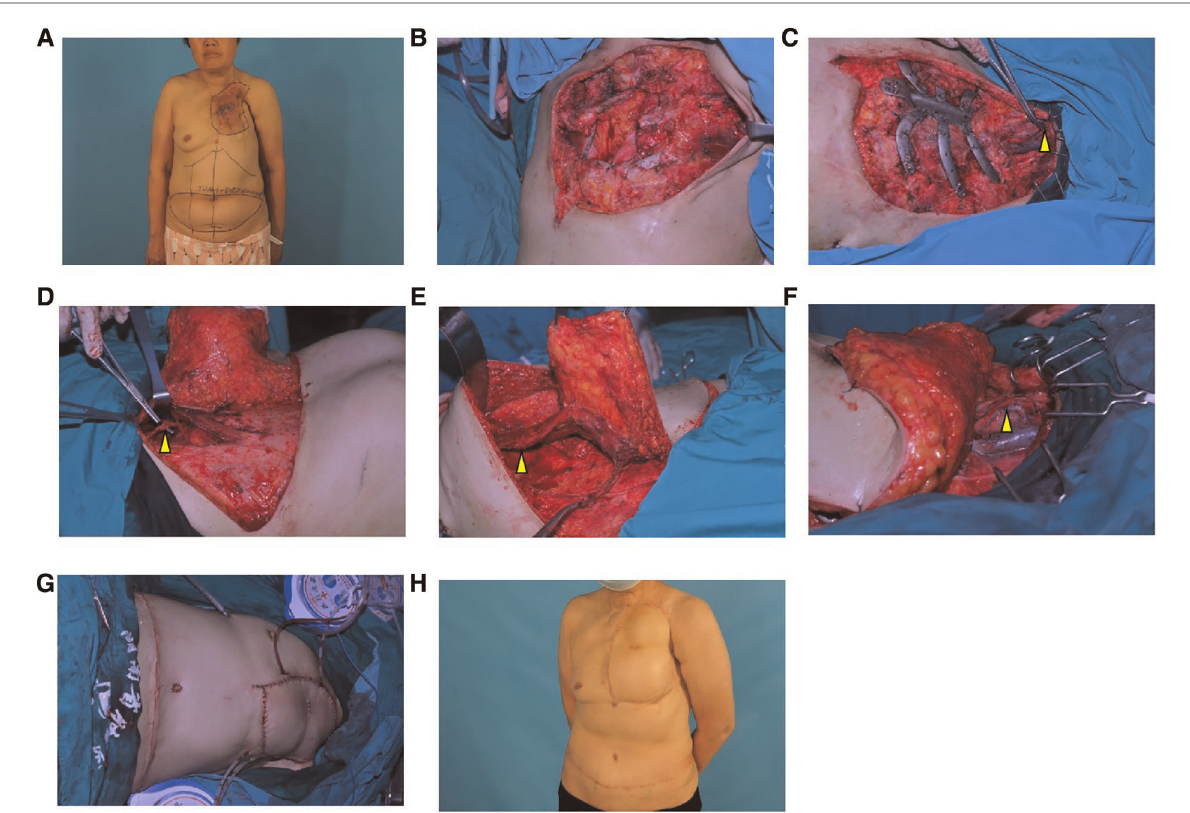
FIGURE 1 Surgical procedure and postoperative appearance of case 1 ( A ), A preoperative photo. We designed a DIEP fl ap in combination with a TRAM fl ap to cover the defect; ( B ), The lesion and involved ribs and sternum were removed, and a large full-thickness defect remained on the chest wall (25 cm× 14 cm); ( C ), A layer of polypropylene knitted nonabsorbable mesh was sutured to the surrounding tissue, and 3D-printed titanium plates were fi xed to the residual ribs. The recipient vessel (the arrow shows the superior thyroid artery and the branch of the jugular vein) was prepared; ( D ), The DIEP fl ap was raised on the left side of the abdomen, and the arrow shows the inferior epigastric artery and vein; ( E ), The TRAM fl ap was raised on the right side of the abdomen. The arrow shows the muscle pedicle; ( F ), The fl ap was transferred to the chest wall, and microsurgical end-to-end anastomosis was performed between the fl ap and the recipient vessels. (The white arrow shows the superior thyroid artery and the yellow arrow shows the branch of the jugular vein.); ( G ), An immediate postoperative photo; ( H ), After 24 months of